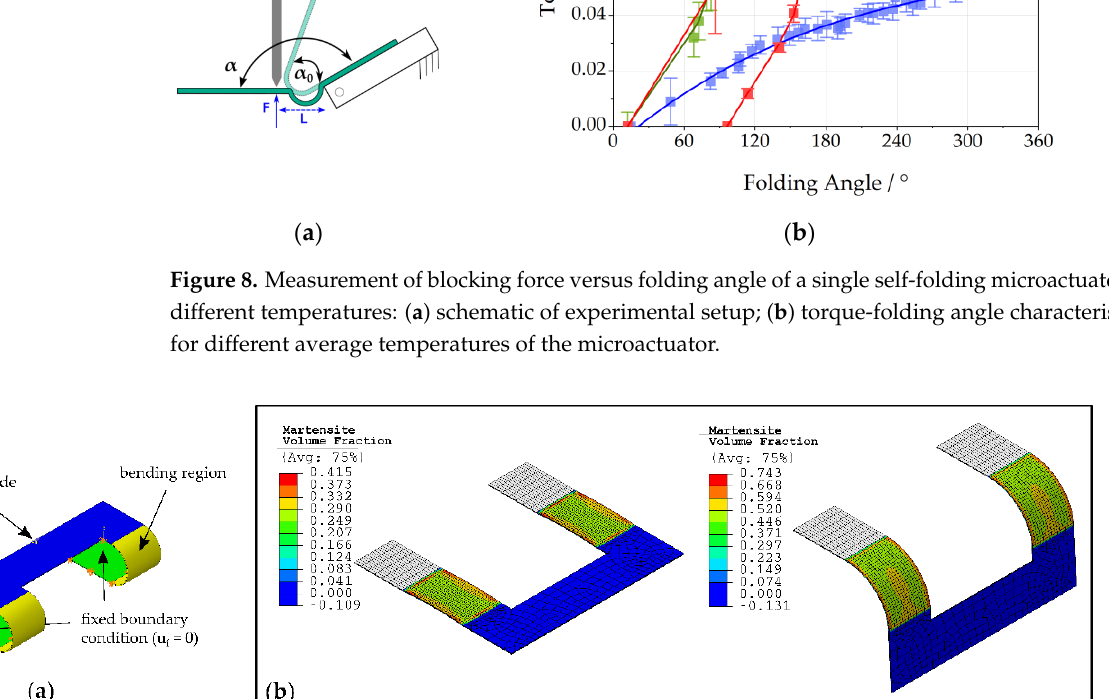
Figure 8. Measurement of blocking force versus folding angle of a single self-folding microactuator at different temperatures: ( a ) schematic of experimental setup; ( b ) torque-folding angle characteris- tics for different average temperatures of the microactuator.